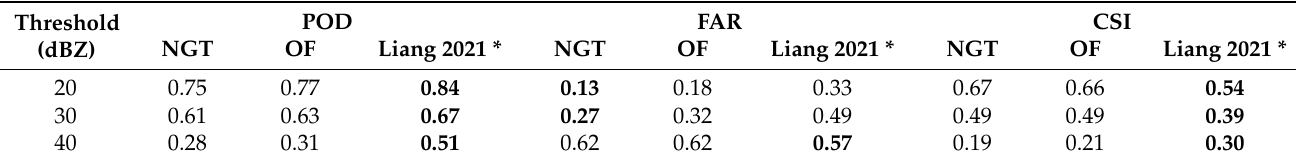
Table 3. Skill scores of two methods for 30 min prediction and the comparison with results from a previous deep learning study. The target time is 11:30 UTC on 21 June